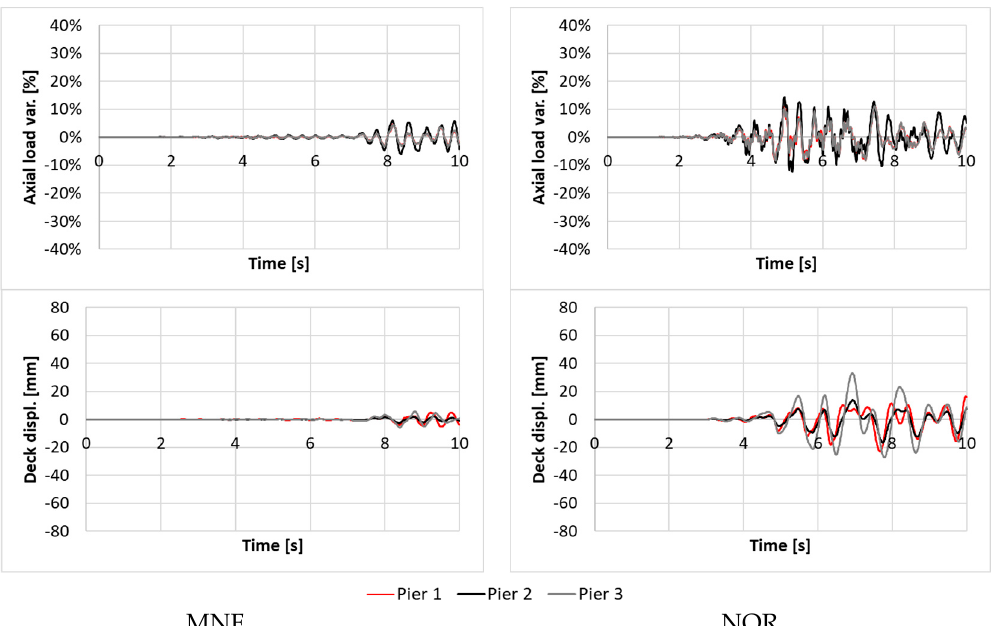
Figure 8. NRHA with scale factor 1.0 (considering both vertical and transversal components: top) Variation of the axial load (from the static load on piers during the seismic event; bottom). Deck displacements.